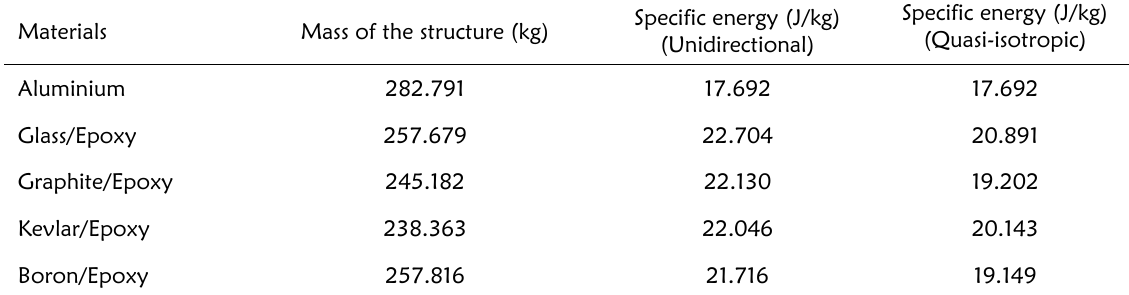
Table 3: Specific energy for different